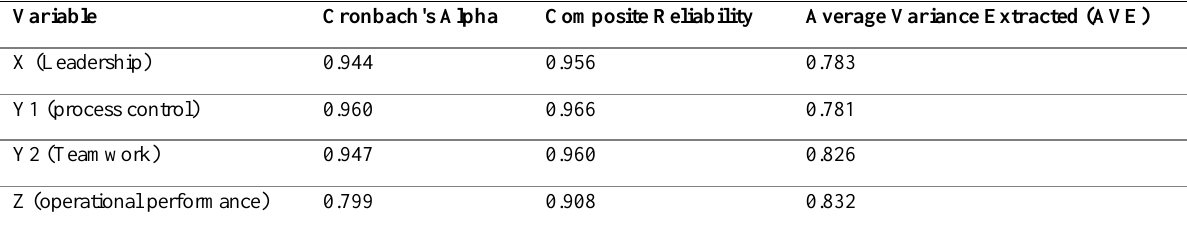
Table 1: Composite Reliability, Cronbach Alpha,